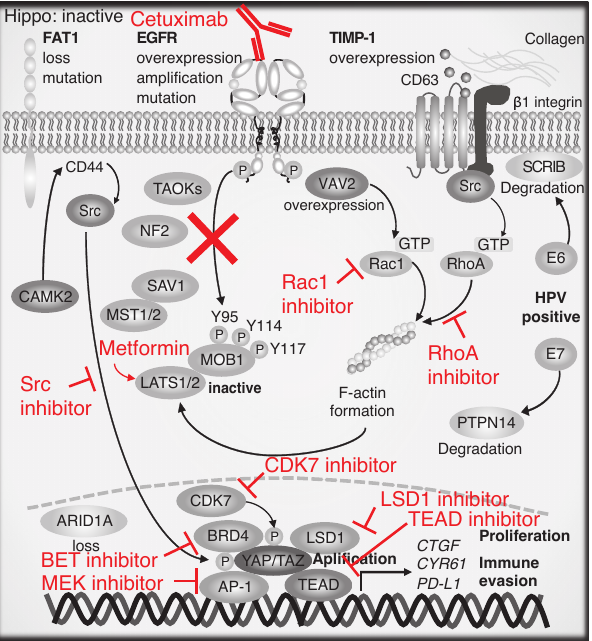
Figure 5. Schematic of therapeutic drugs targeting the Hippo pathway and YAP/TAZ in HNSCC. Metformin, Src, RhoA, Rac1, BET, LSD1, MEK, CDK7, and TEAD inhibitors are poten- tial drugs for HNSCC treatment. AMPKa2 denotes AMP-activated catalytic subunit alpha 2 (also abbreviated